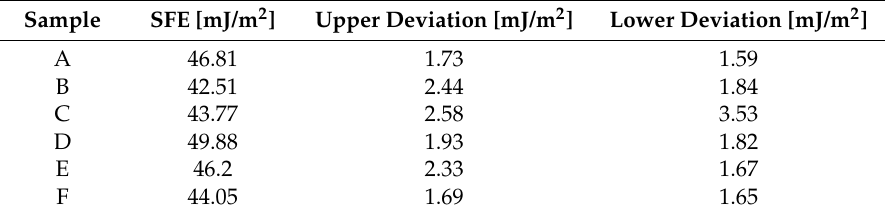
Table 9. Surface free energy